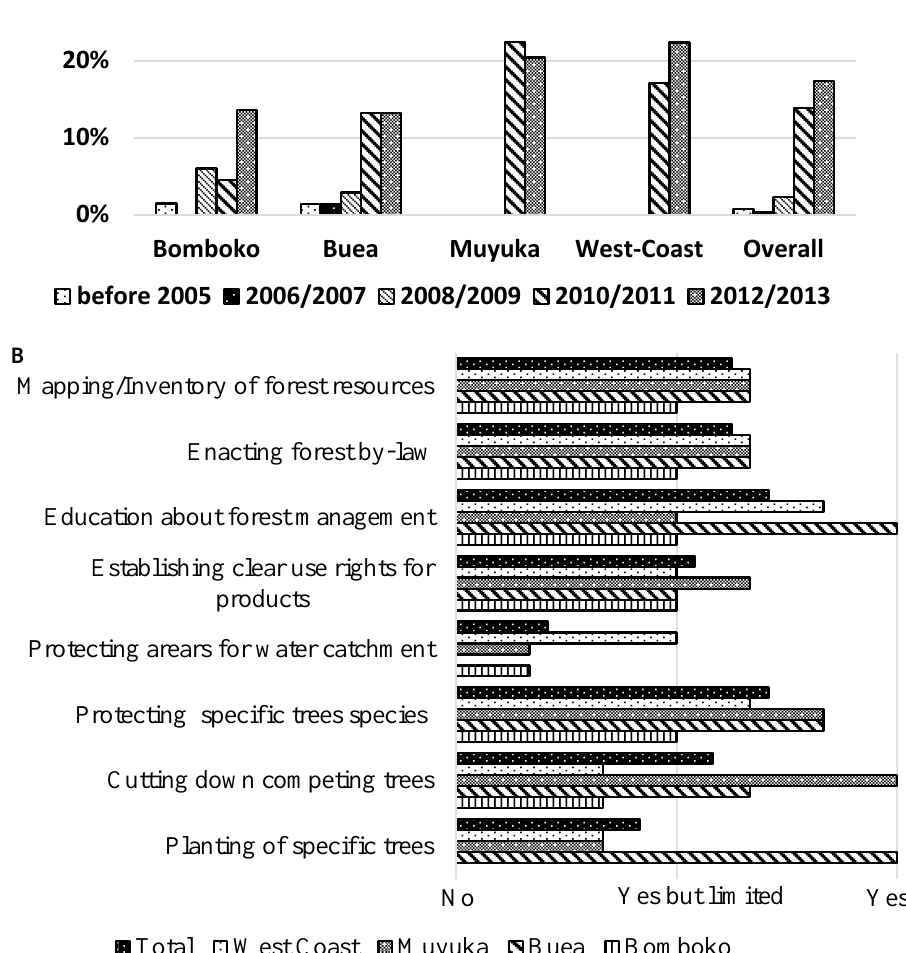
Figure 3. Increased percentage of participants engaged in forest projects with the launch of MCNP ( A ) and common forest practices before the launching of the park ( B ).